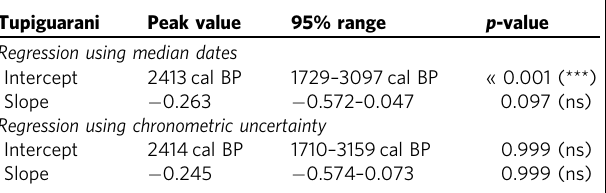
Table 3 Regression results for the tupiguarani